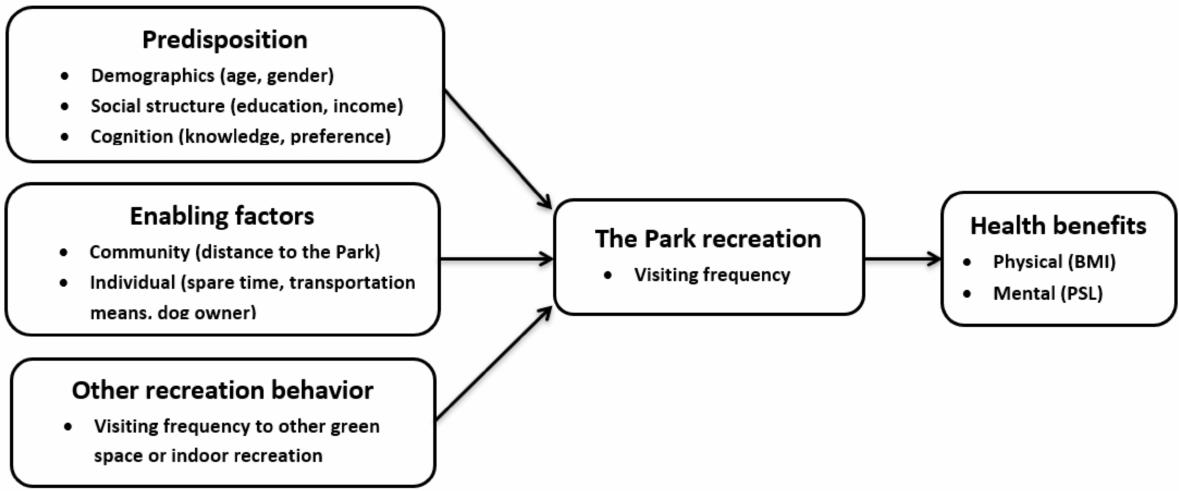
Figure 2. Conceptual framework of the